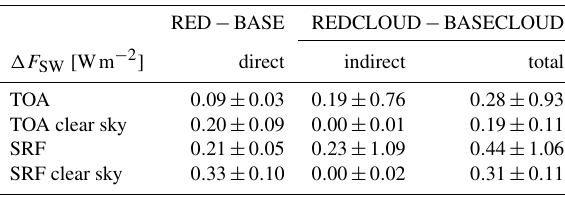
Table 2. Aerosol direct and indirect effects on the shortwave radi- ation flux at the top of atmosphere (TOA) and surface (SRF) over Europe for May compared to baseline scenario. Note that direct ef- fects are derived from BASE and RED simulations, and indirect and total (i.e., direct plus indirect) effects from BASECLOUD and REDCLOUD. The indirect effect of clear-sky estimation is obvi- ously equal to zero, but it was included to confirm the validity of the